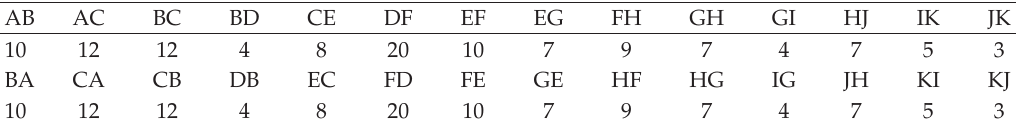
Table 1: Table of delays.